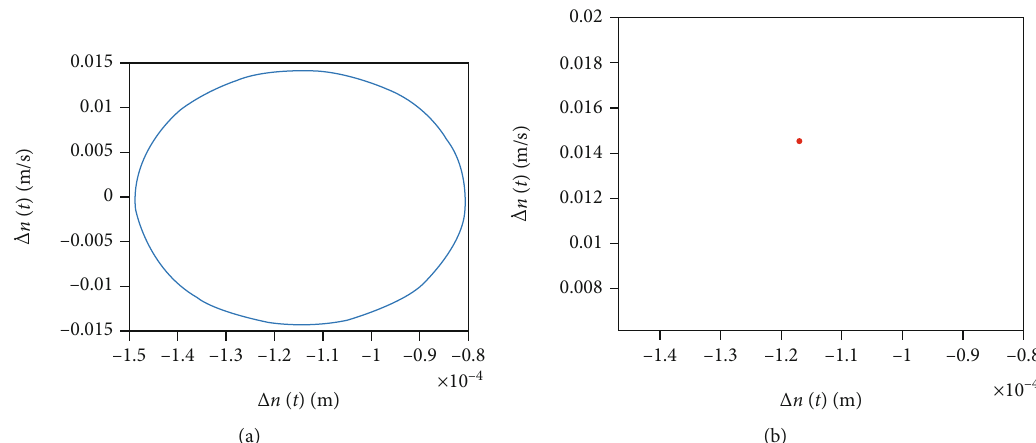
Figure 10: When the misalignment in the x direction is 2 : 73 × 10 − 4 m: (a) relative displacement velocity and (b) the corresponding diagram of Poincare.